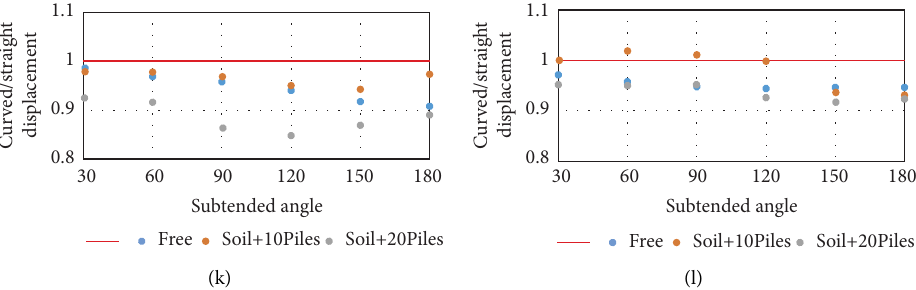
Figure 24: Curved/straight column displacement ratios of the middle column predicted at (a) DBE, (b) MCE levels, side column at (c) DBE, (d) MCE levels in the tangential direction; ratios predicted for middle column at (e) DBE, (f) MCE levels, side column with GMs compatible to (g) DBE, (h) MCE levels in the radial direction, curved/straight real column displacement ratios of the middle column at (i) DBE, (j) MCE levels, side column at (k) DBE, (l) MCE